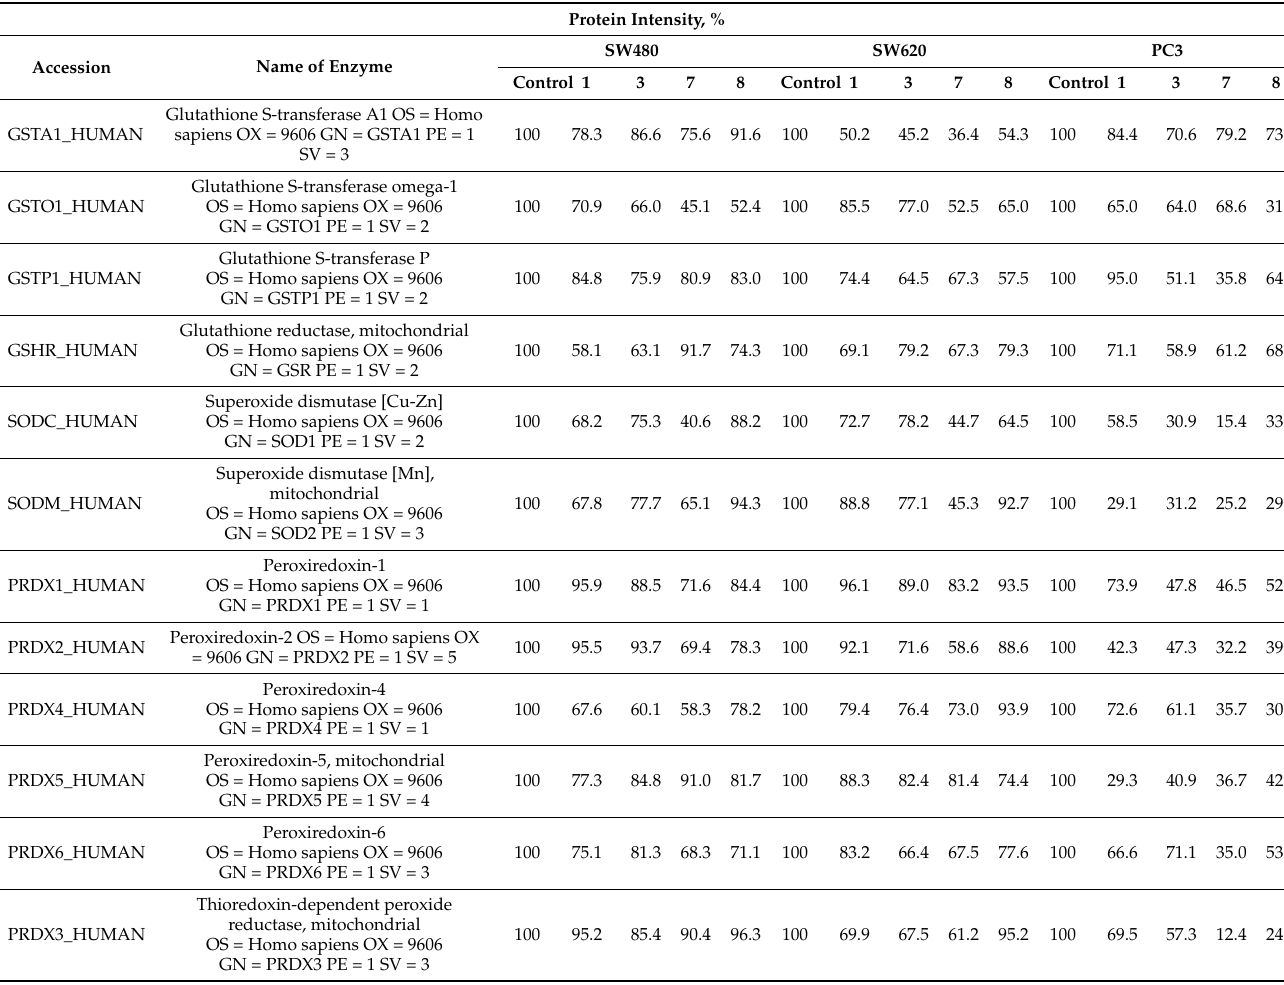
Table 3. Liquid chromatography–mass spectrometry (LC–MS) proteome analysis provided in the SW480, SW620 and PC3 cells treated for 24 h with IC 50 concentrations of complexes 1 , 3 , 7 and 8 . Protein intensities were expressed as percentage of a control. Protein Intensity,